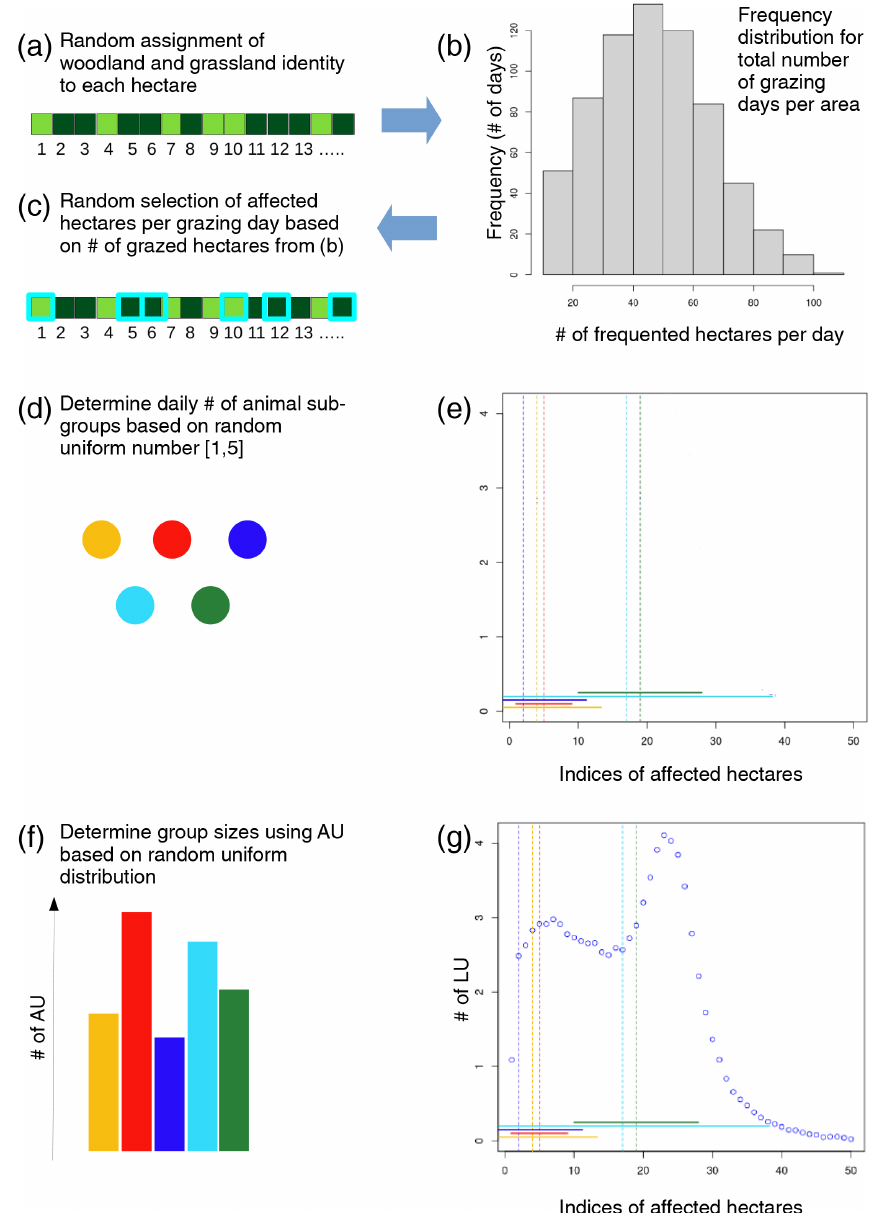
Figure 3. Illustration of the steps involved in creating the hectare-specific grazing